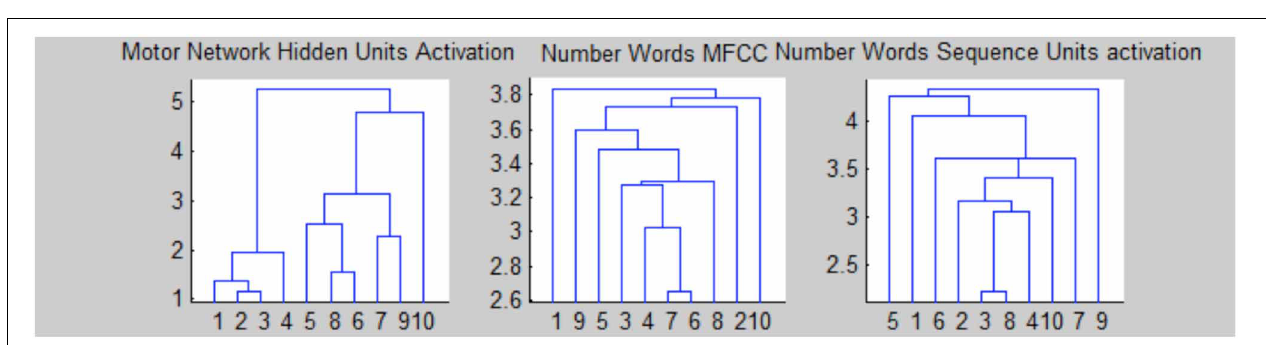
FIGURE 5 | Optimal leaf-order of hidden units’ activations.